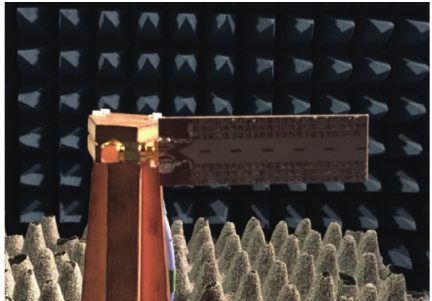
Figure 12: Far field measurement setup with the fabricated prototype.